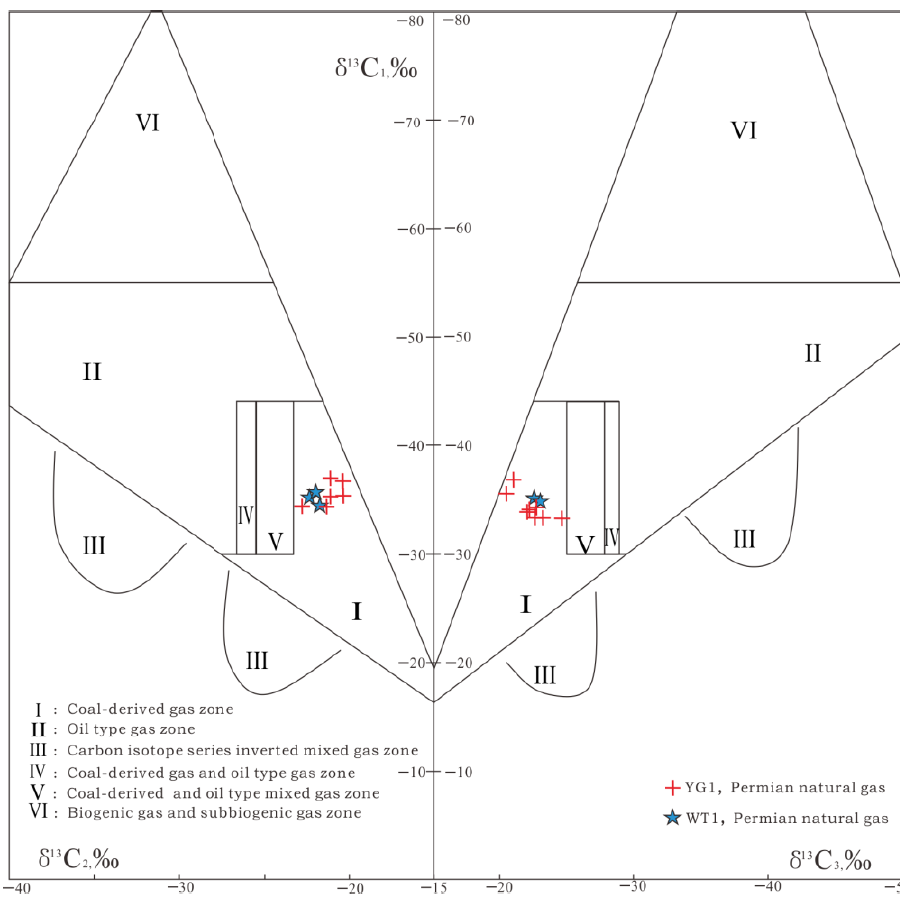
Figure 9. Origin of Permian natural gas in the Wumaying buried hill.